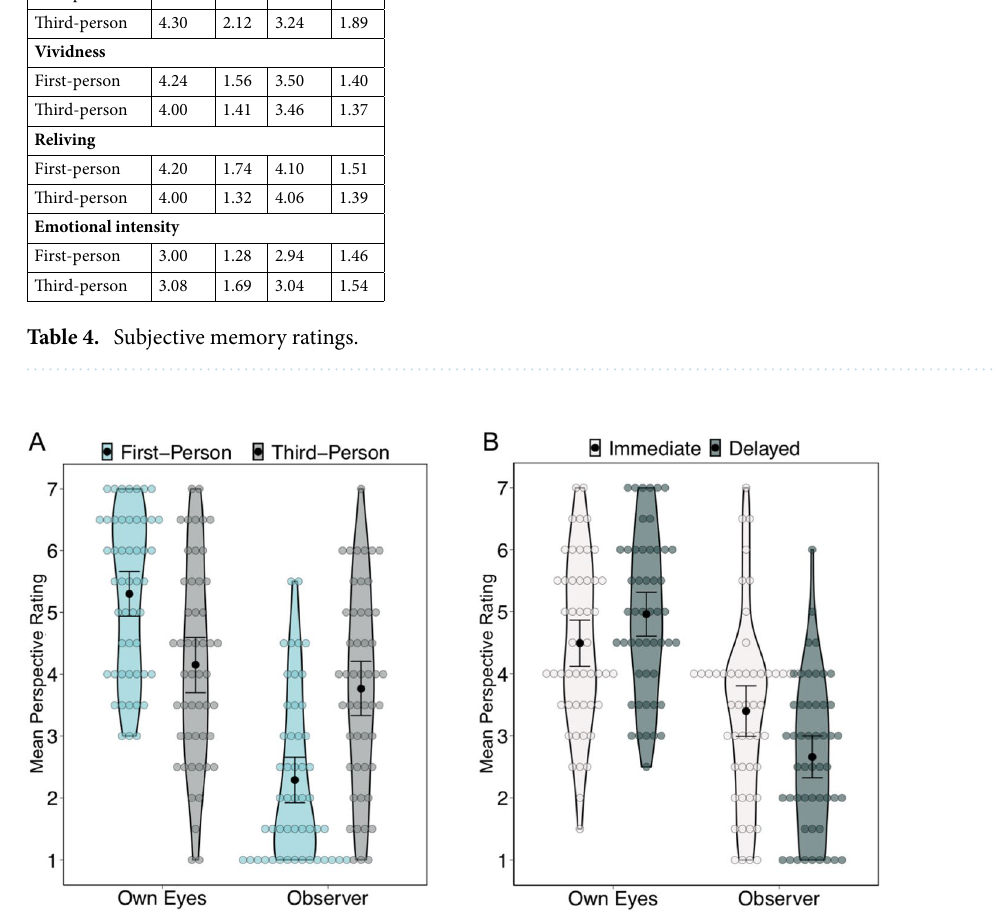
Figure 5. Visual perspective ratings. ( A ) Own eyes ratings were higher for memories of events experienced from a first-person than a third-person avatar perspective, whereas observer ratings were higher for third- person than first-person avatar perspectives. ( B ) Own eyes ratings were higher in memories retrieved following a delay, whereas observer ratings were lower following a delay. Colored circles reflect mean for each participant, black circles represent the mean within each condition, and error bars reflect the 95%